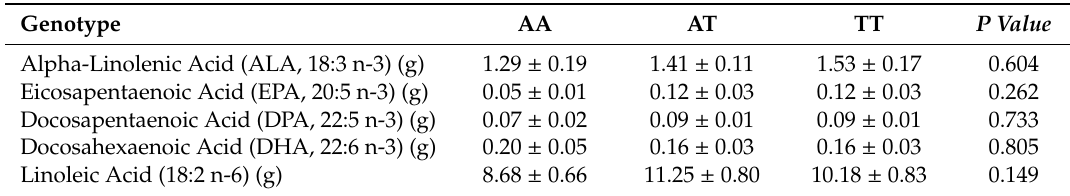
Table 3. Average daily fatty acid intake of the studied cohort based on their FTO rs9939609 genotype. Values are expressed as mean ±